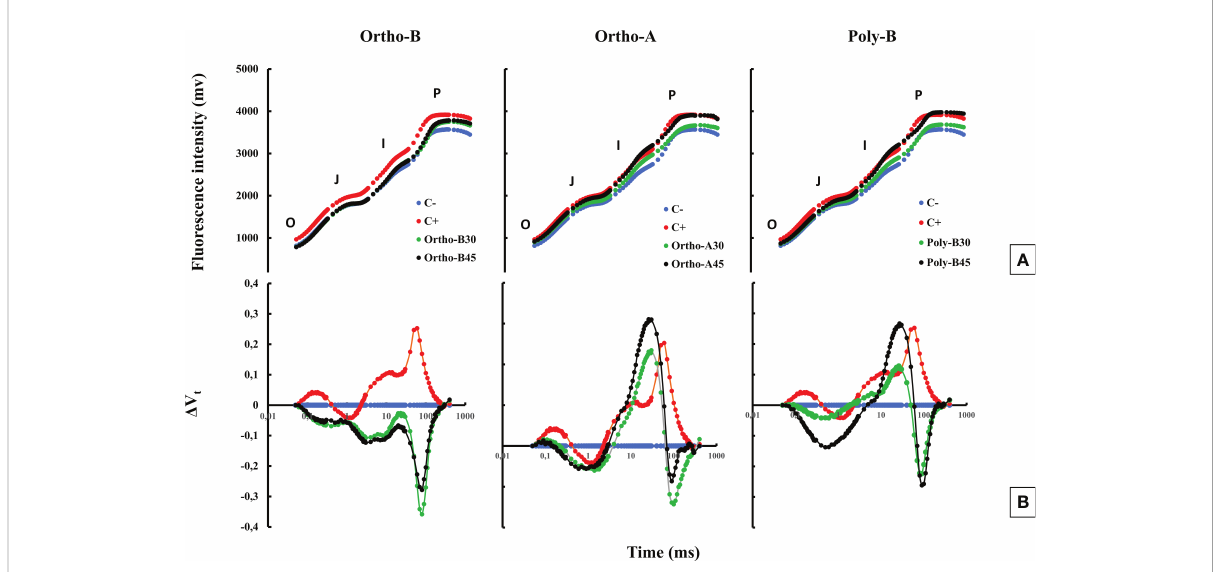
FIGURE 2 ThecombinedeffectofP-fertilizerforms(Ortho-A,Poly-BandOrtho-B)anddoses(0,30and45ppm)onOJIPcurves (A) and D Vt fl uorescenceparameter (B) ofwheatplantsgrownundersaltstressconditionsat12WAS.C-:unfertilizedplantswithoutsaltapplication,C+salt-stressedandunfertilizedplants. FIGURE 3 The combined effect of P-fertilizer forms (Ortho-A, Poly-B and Ortho-B) and doses (0, 30 and 45 ppm) on Photosynthetic Performance Index (PI tot) of wheat plants grown under salt stress conditions, measured at 6, 8, 10 and 12 WAS. C-: unfertilized plants without salt application, C+ salt-stressed and unfertilized plants. Statistical analysis was performed using one-way ANOVA and SPSS data processing software. GT2 of